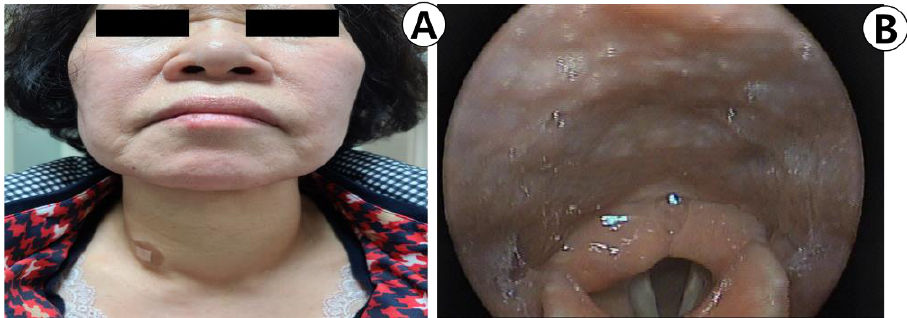
Figure 2. ( A ) Photograph of the patient in the emergency room. Symmetrical diffuse swelling of the anterior neck is observed. ( B ) Laryngoscopic view of retropharyngeal wall swelling on admission day. Both thyroid lobes exhibited diffuse swelling and heterogeneous contrast enhancement on neck computed tomography. No airway obstruction was observed. The anterior neck, parapharyngeal space, retropharyngeal space, and upper mediastinum exhibited increased soft-tissue density without any contrast enhancement (Figure 3A,B).